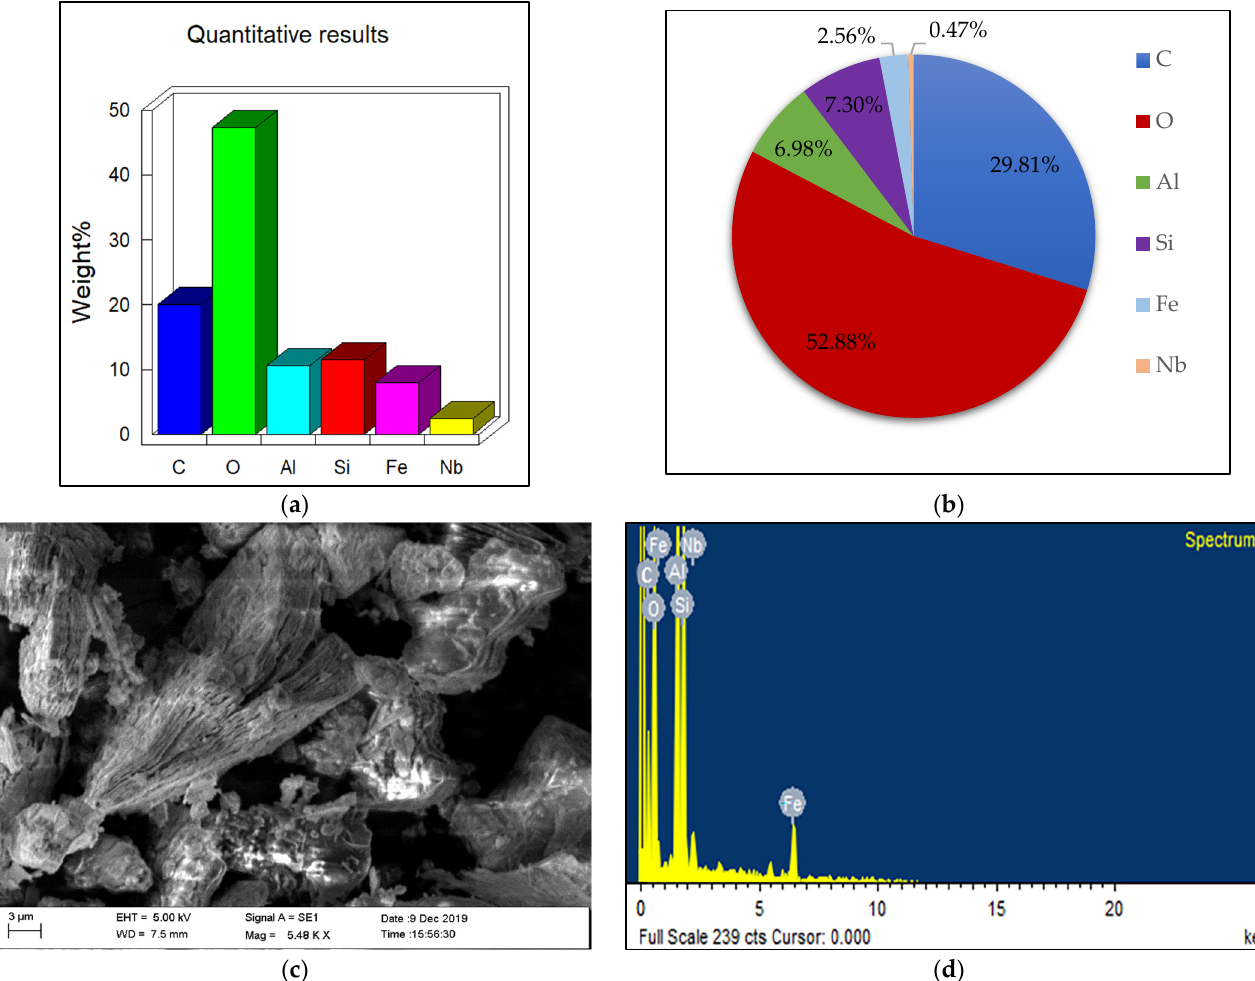
Figure 9. EDS analysis of Kolalgiri sample; ( a ) elements weight (%), ( b ) atomic weight (%), ( c ) SEM image, ( d ) spectrum image.